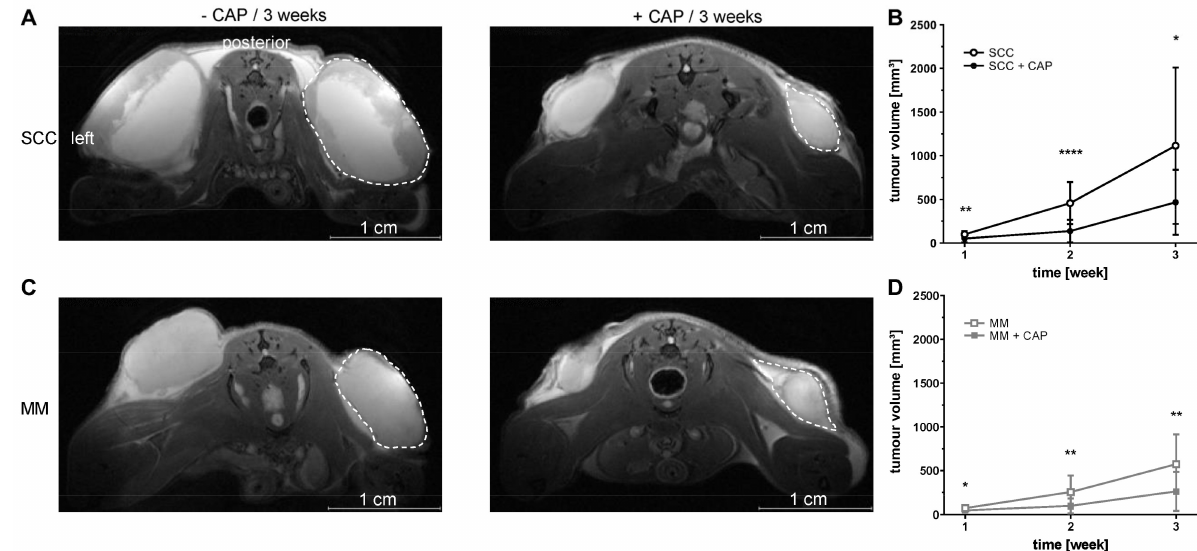
Figure 2. Representative MR images ( A , C ; T2 weighted, axial) and quantitative assessment of tumour volumes ( B , D ). NSG mice with s.c. flank tumours, either squamous cell carcinoma (SCC) or malignant melanoma (MM), were treated with or without cold atmospheric pressure plasma (CAP) over three weeks. CAP treatment started four days after tumour cell injection and was repeated every four days. CAP treatment caused a significant reduction in both SCC and MM growth over the three-week observation time. Empty symbols represent untreated tumours, and filled symbols represent CAP-treated tumours. Data are presented as mean ± SD ( n = 20–24 samples per time point); two-way ANOVA followed by Bonferroni correction for multiple comparison. * p ≤ 0.05; ** p ≤ 0.01; **** p ≤ 0.0001 vs. untreated SCC or MM, respectively. Dotted line mark right tumour volume. Table 1. Data of apparent diffusion coefficient, assessed from diffusion-weighted MR imaging. NSG mice with two s.c. flank tumours, either squamous cell carcinoma (SCC) or malignant melanoma (MM), were treated with or without cold atmospheric pressure plasma (CAP) over three weeks. CAP treatment started four days after tumour cell injection and was repeated every four days. Data are presented as mean ± SD ( n = 12–20 samples per time point); Mixed-effects analysis followed by Bonferroni correction for multiple